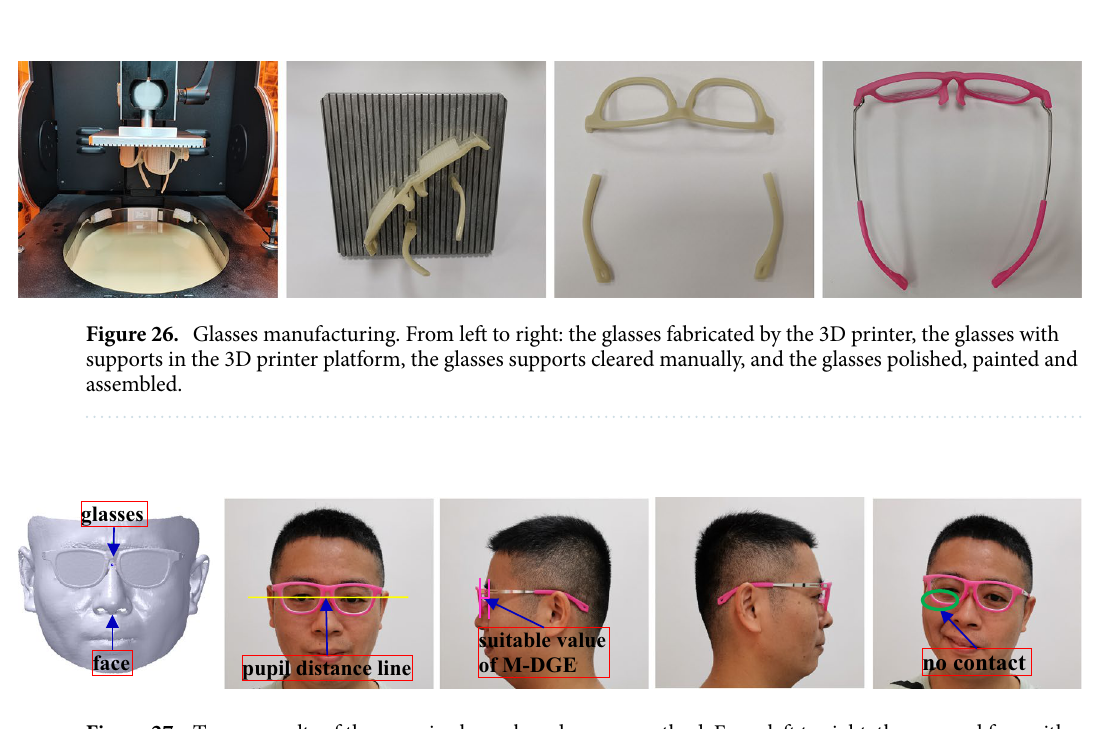
Figure 27. Try-on results of the myopic glasses based on our method. From left to right: the scanned face with glasses, the front view, the left view, the right view, the front view with a great expression.